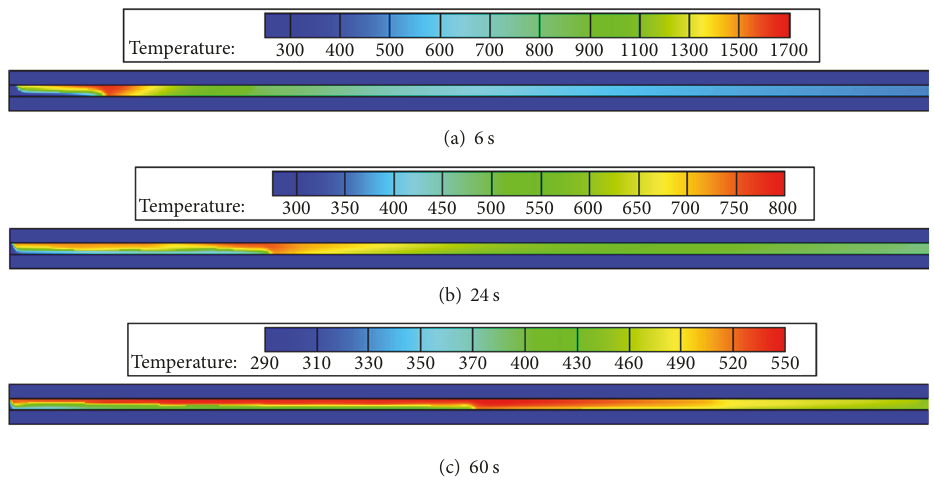
Figure 5: Temporal and spatial variation of temperature in the open tunnel.